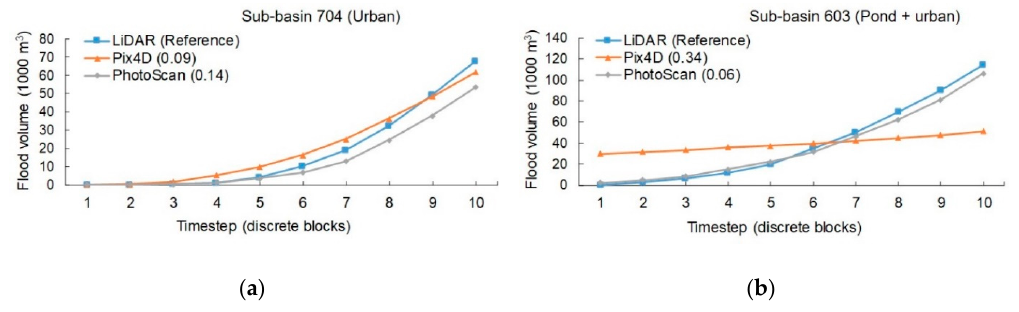
Figure 9. This is a figure, Similarity of flood progression curves compared to LiDAR at 704 ( a ) and 603 ( b ) sub-basins. Bray-Curtis index is shown in brackets. Volume is given in 1k cubic meters (m 3